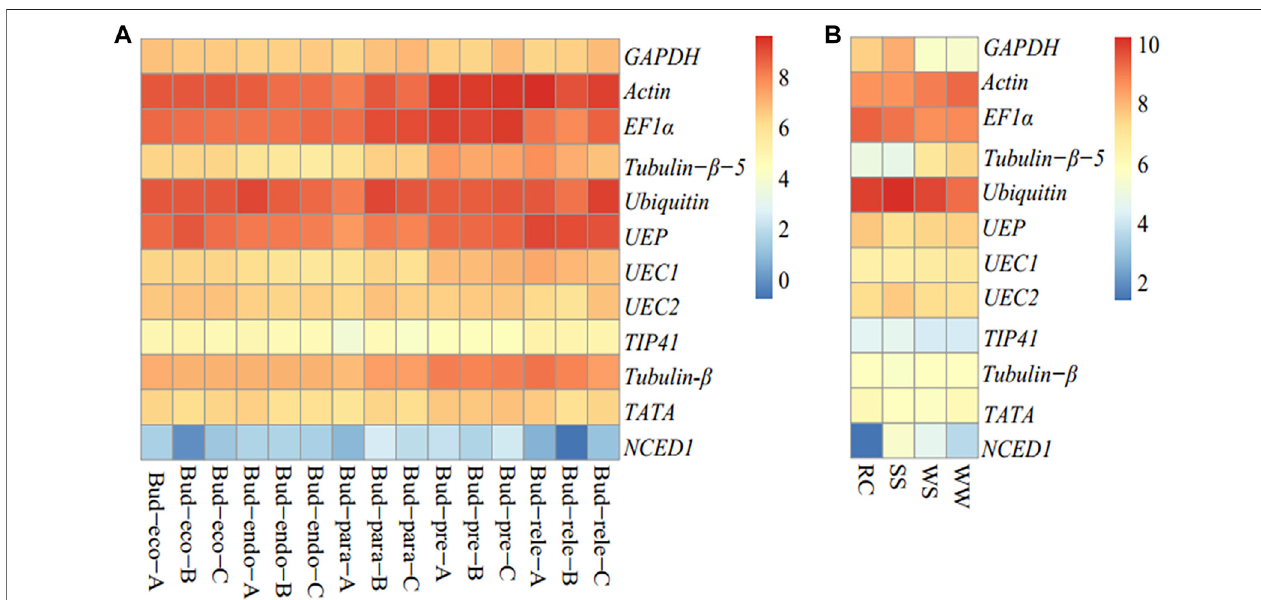
FIGURE 4 | Gene (eleven candidate reference genes and NCDE1 ) expression based fragments per kilobase of transcript per million mapped reads (log2 transformation) in R. delavayi . (A) Dormant buds from the study with accession SRA = PRJNA476831 (available at https://www.ncbi.nlm.nih.gov/bioproject/476831), pre-dormancy (Bud-pre, 07/20/2015), para-dormancy (Bud-para,10/29/2015), endo-dormancy(Bud-endo,12/02/2015), eco-dormancy(Bud-eco,12/27/2015), and dormancy-release (Bud-rele, 01/14/2016)). (B) Drought stress condition from the study of Cai et al. (2019) (SRA = PRJNA503304) (four experimental scenarios were designed: normal irrigation (WW), stopping irrigation for 5 days (WS), stopping irrigation for 9 days (SS), and re-watering for 6 h (REC) after 10 days of drought. Rewatering was only carried out on 10 plants. The other fi ve plants were continued under no irrigation for subsequent electron microscopic observation. All the measurements were carried out at the end of each timepoint).